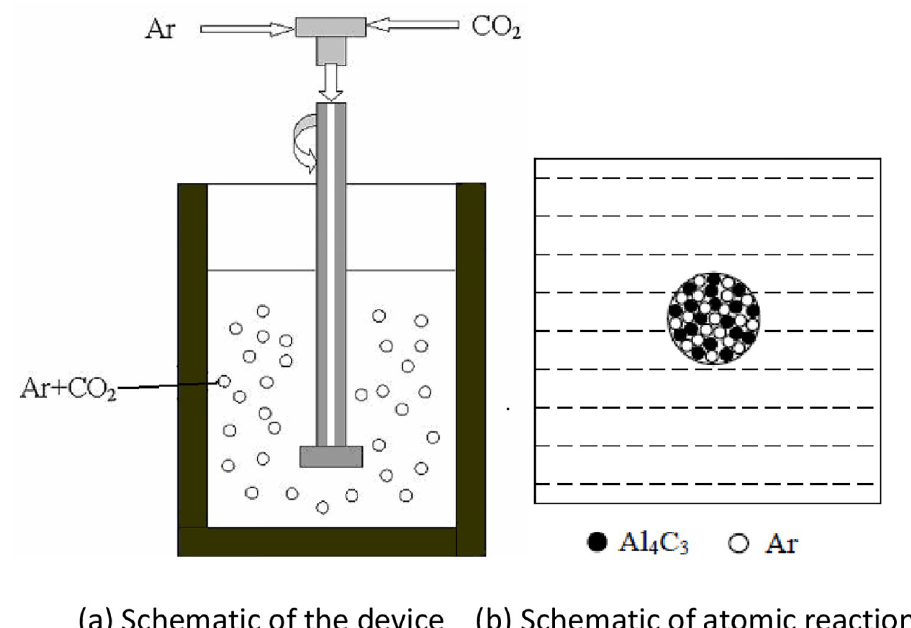
Fig 1. Schematic of refinement principle based on the rotary injection of Ar+CO 2 . (a) Schematic of the device; (b) Schematic of atomic reaction.